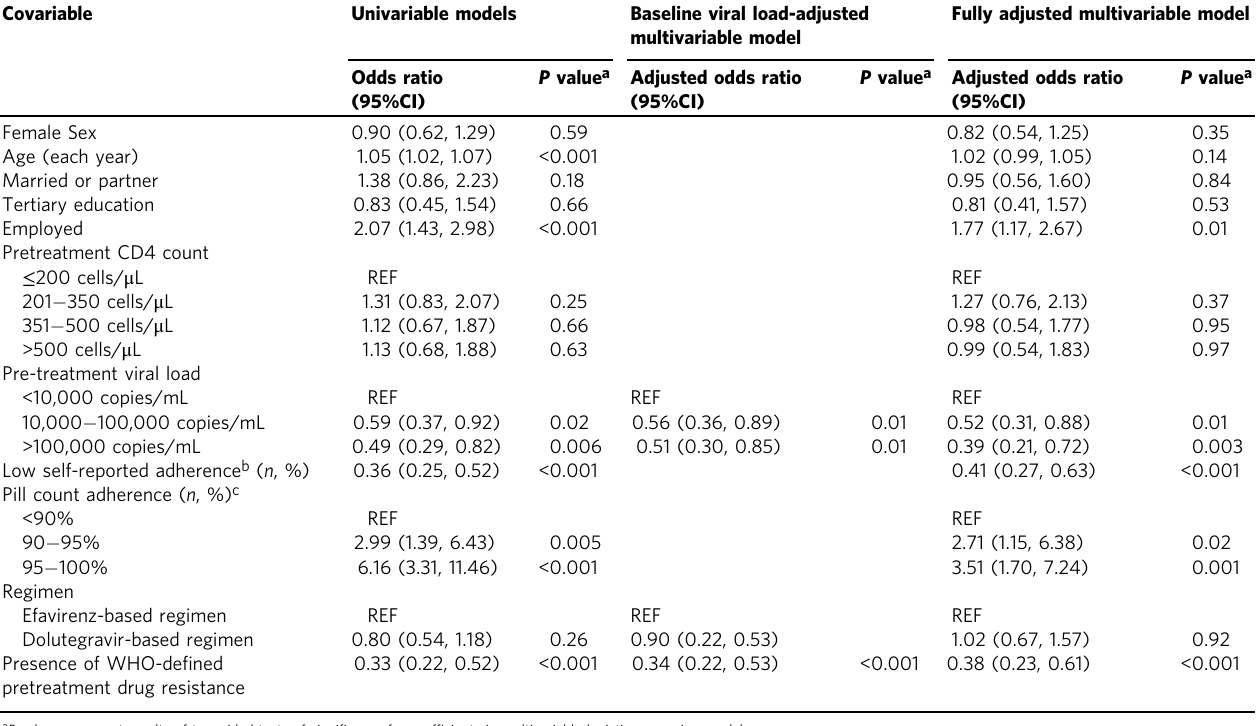
Table 3 Logistic regression models for 96-week virologic success in the ADVANCE Trial (virologic success in our primary outcome was de fi ned as achievement of a sustained viral load <1000 copies/mL from 12 weeks, <200 copies/mL from 24 weeks, and <50 copies/mL from 48 weeks onwards. Individuals who are censored after 48 weeks with virologic suppression are considered as achieving virologic success).